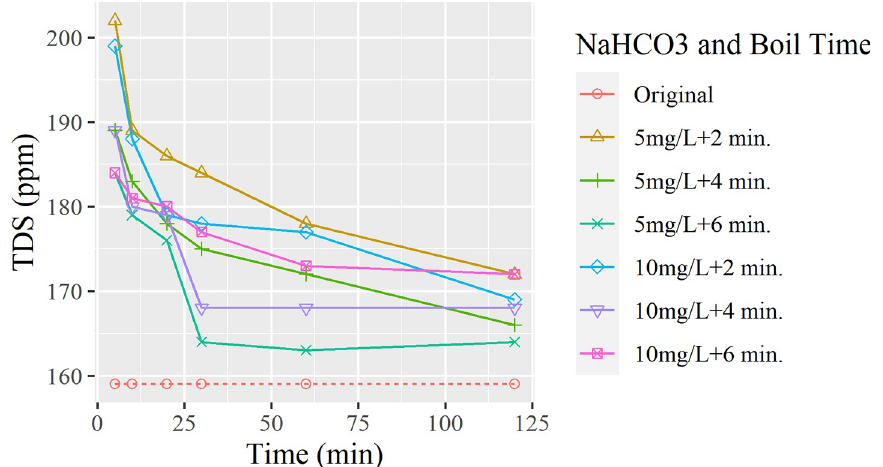
Fig 9. Trend for the effect of NaHCO3 on boiling water TDS.